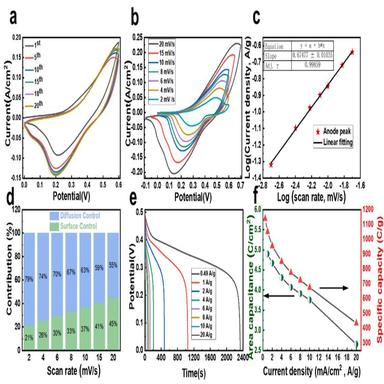
The electrochemical performance of NCAP@LDHs. The CV response curves at initial 20 cycles (a), the CV response under different scan rates (b), the linear fitting result (c), the contribution of two different control processes (d), the discharge curves (e), and the relative specific capacity of NCAP@LDHs (f).